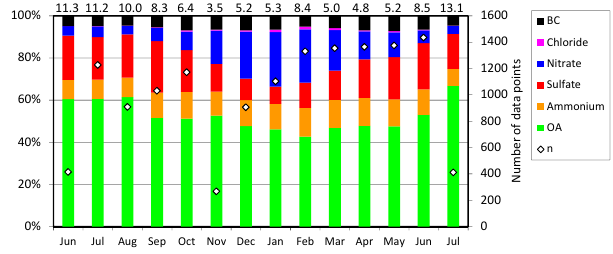
aerosol. The numbers at the top of each bar represent the aver- age monthly concentration. n is the number of data points for each month (right